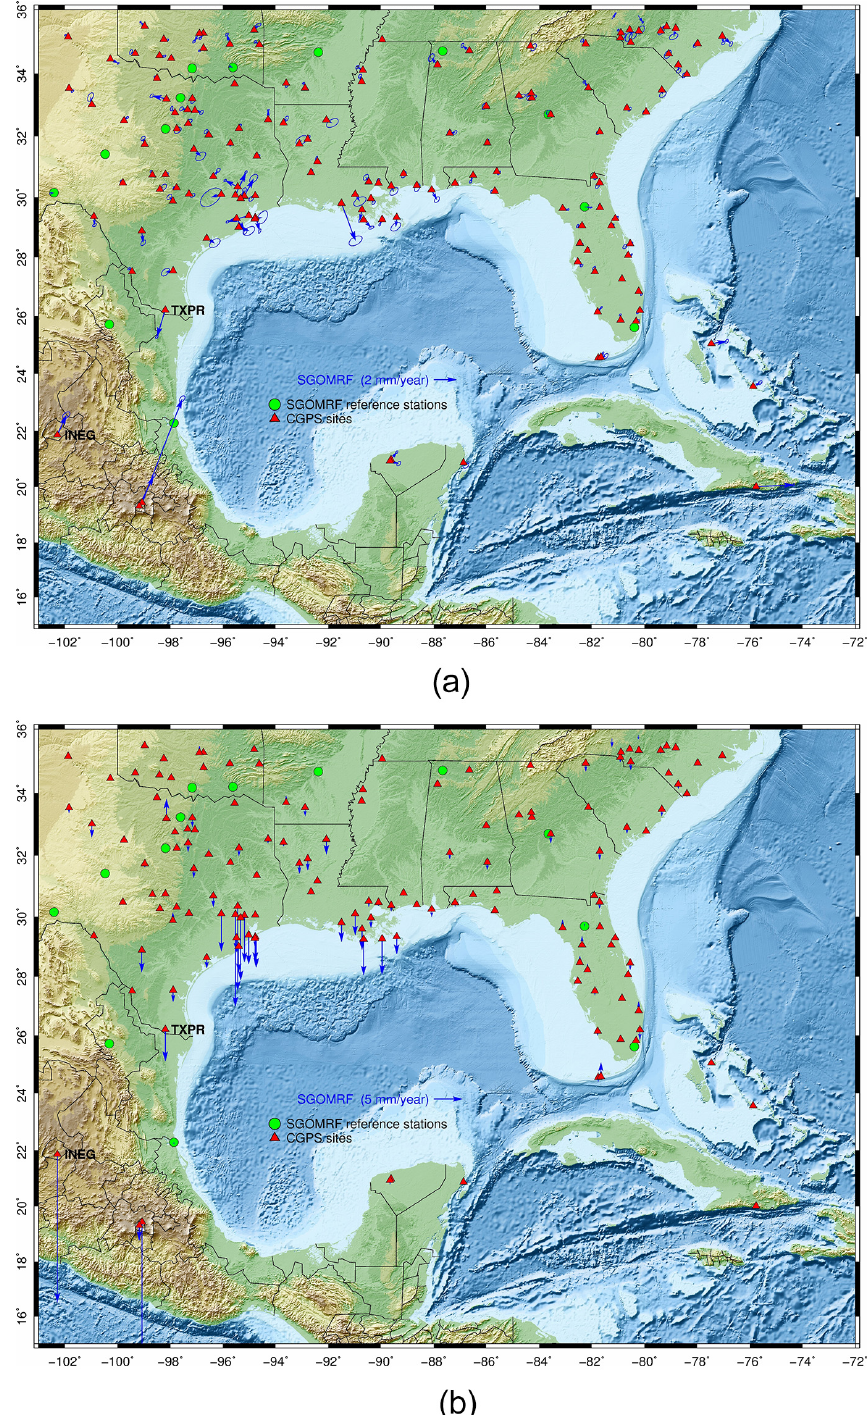
Figure 4. (a) Horizontal velocity with 95% confident ellipses and (b) vertical velocity vectors of 148 CGPS stations ( > 4 years) in the Gulf of Mexico region. Green dots represent the 13 reference stations. The blue vectors represent the average velocities referred to